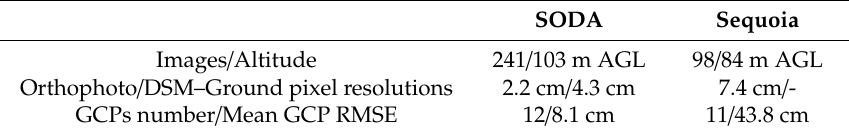
Table 3. Acquisition parameters of the created orthophoto and DSM from two